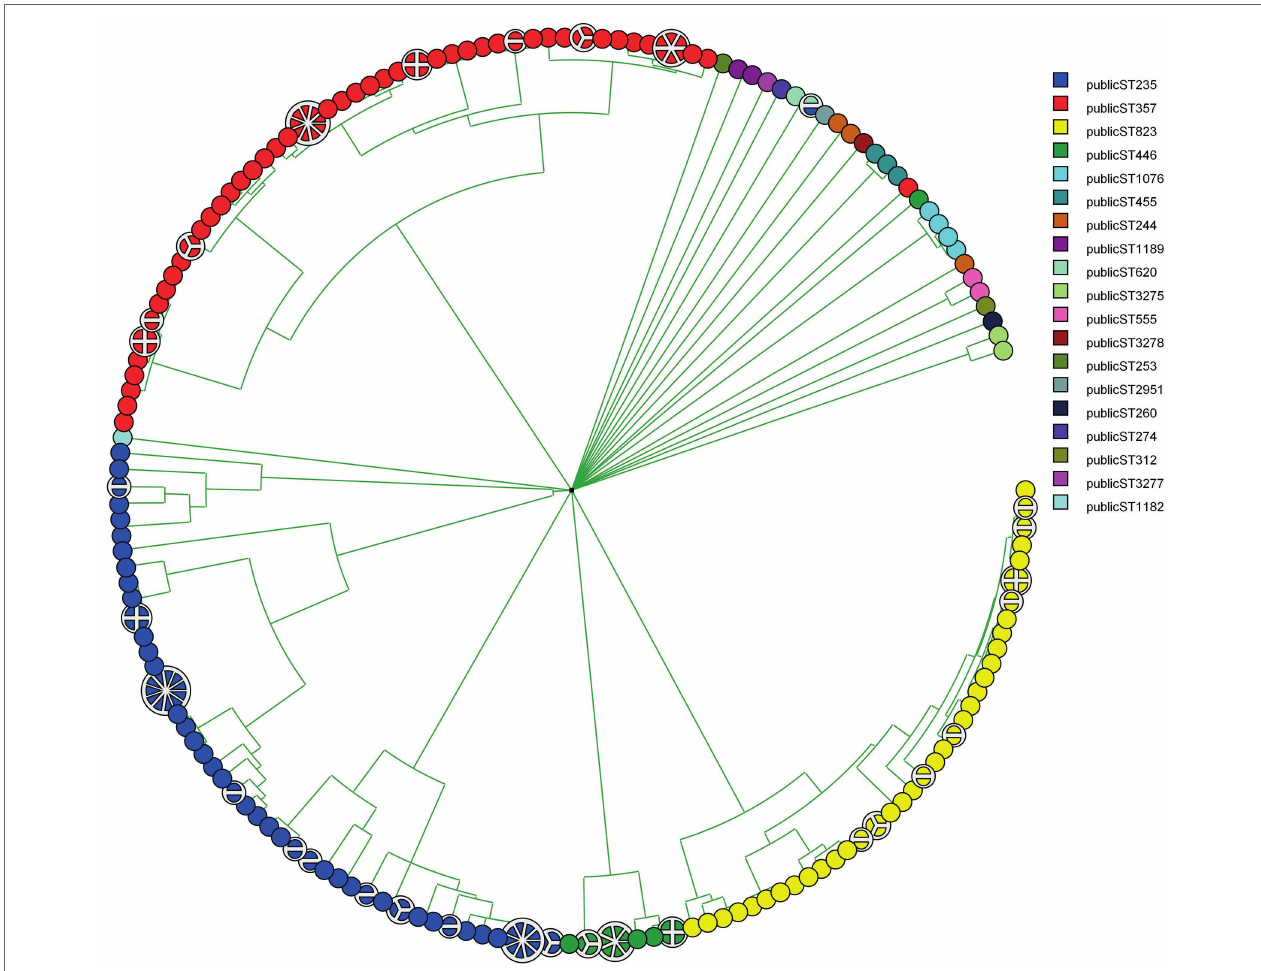
FIGURE 2 | Phylogenetic tree showing CNPA relatedness based on wgMLST. Subgrouping with in each ST (denoted by different colors) is labeled by the original source (patient ID or environmental source) from which these strains have been